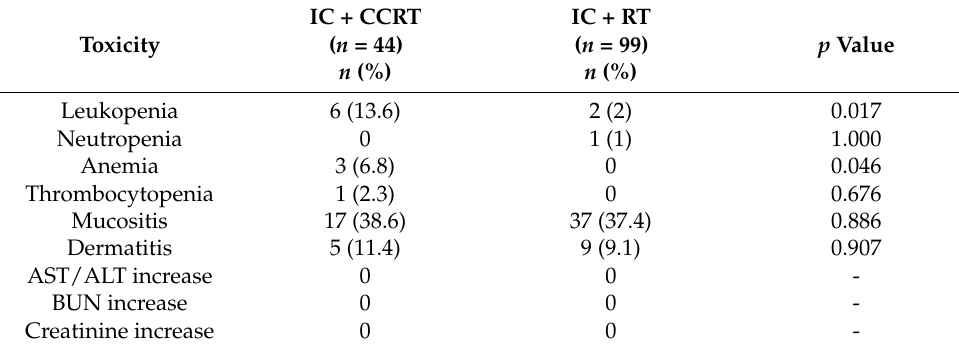
Table 3. Incidences of grade 3–4 treatment-related toxicities for the PSM